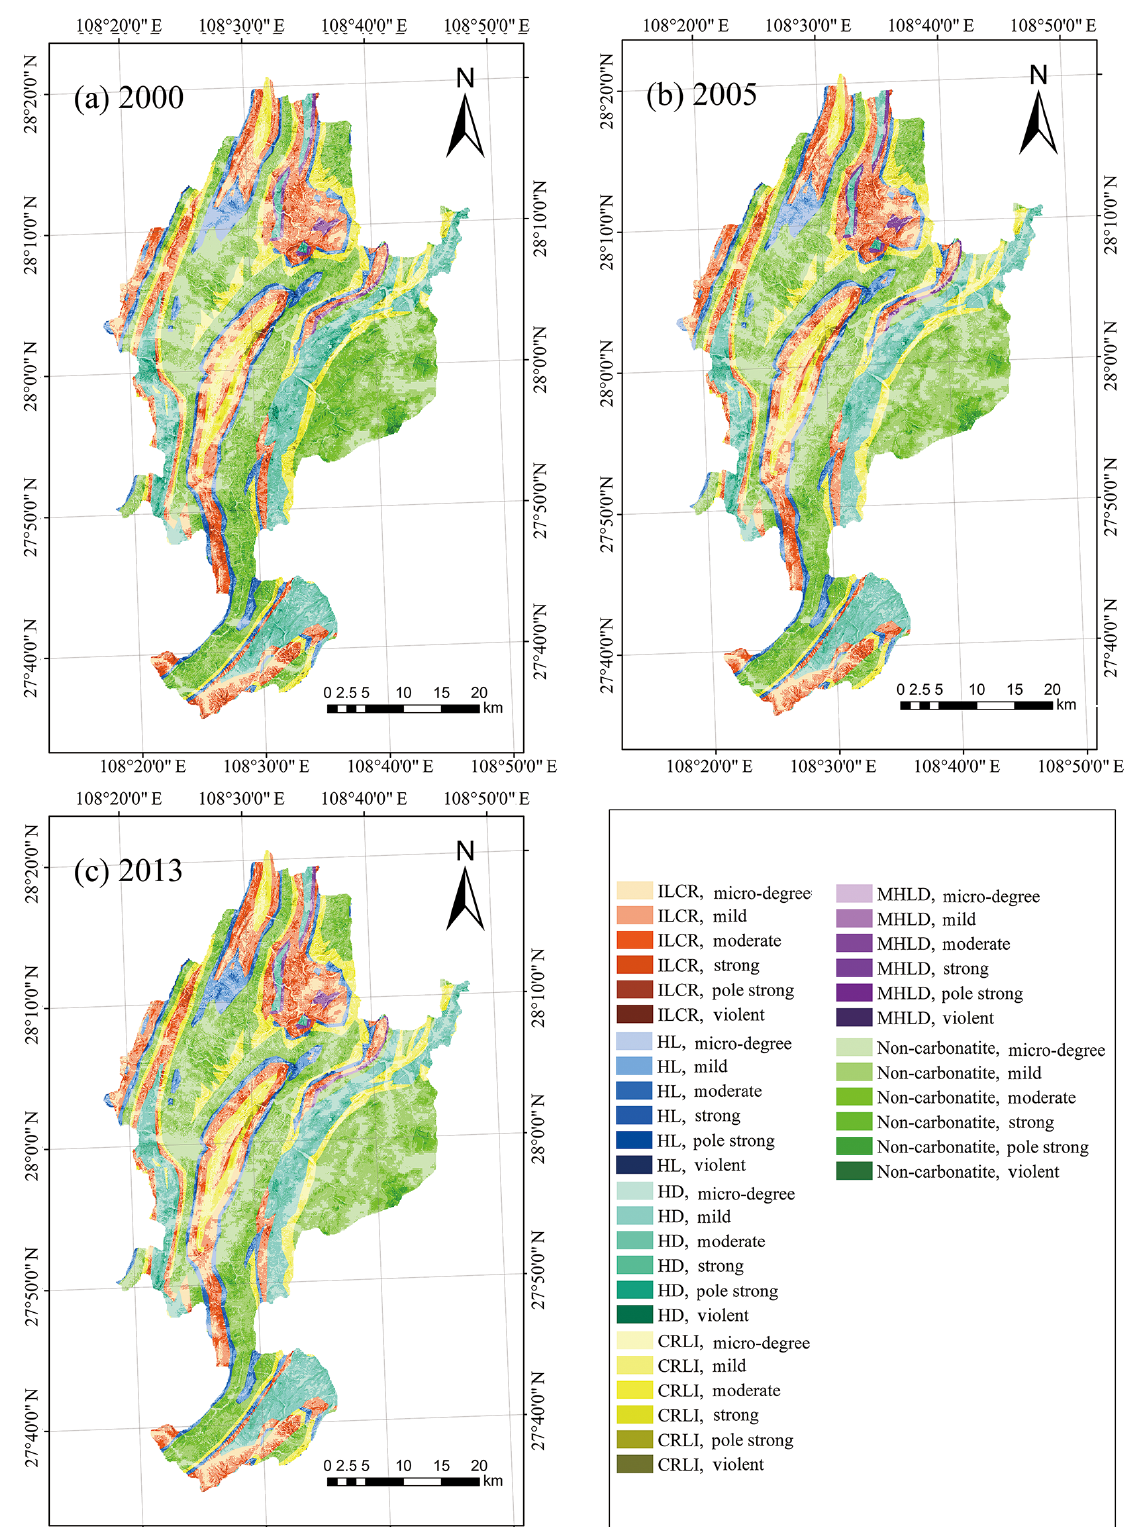
Figure 7. Spatial distribution of soil erosion in different rock outcrop areas.